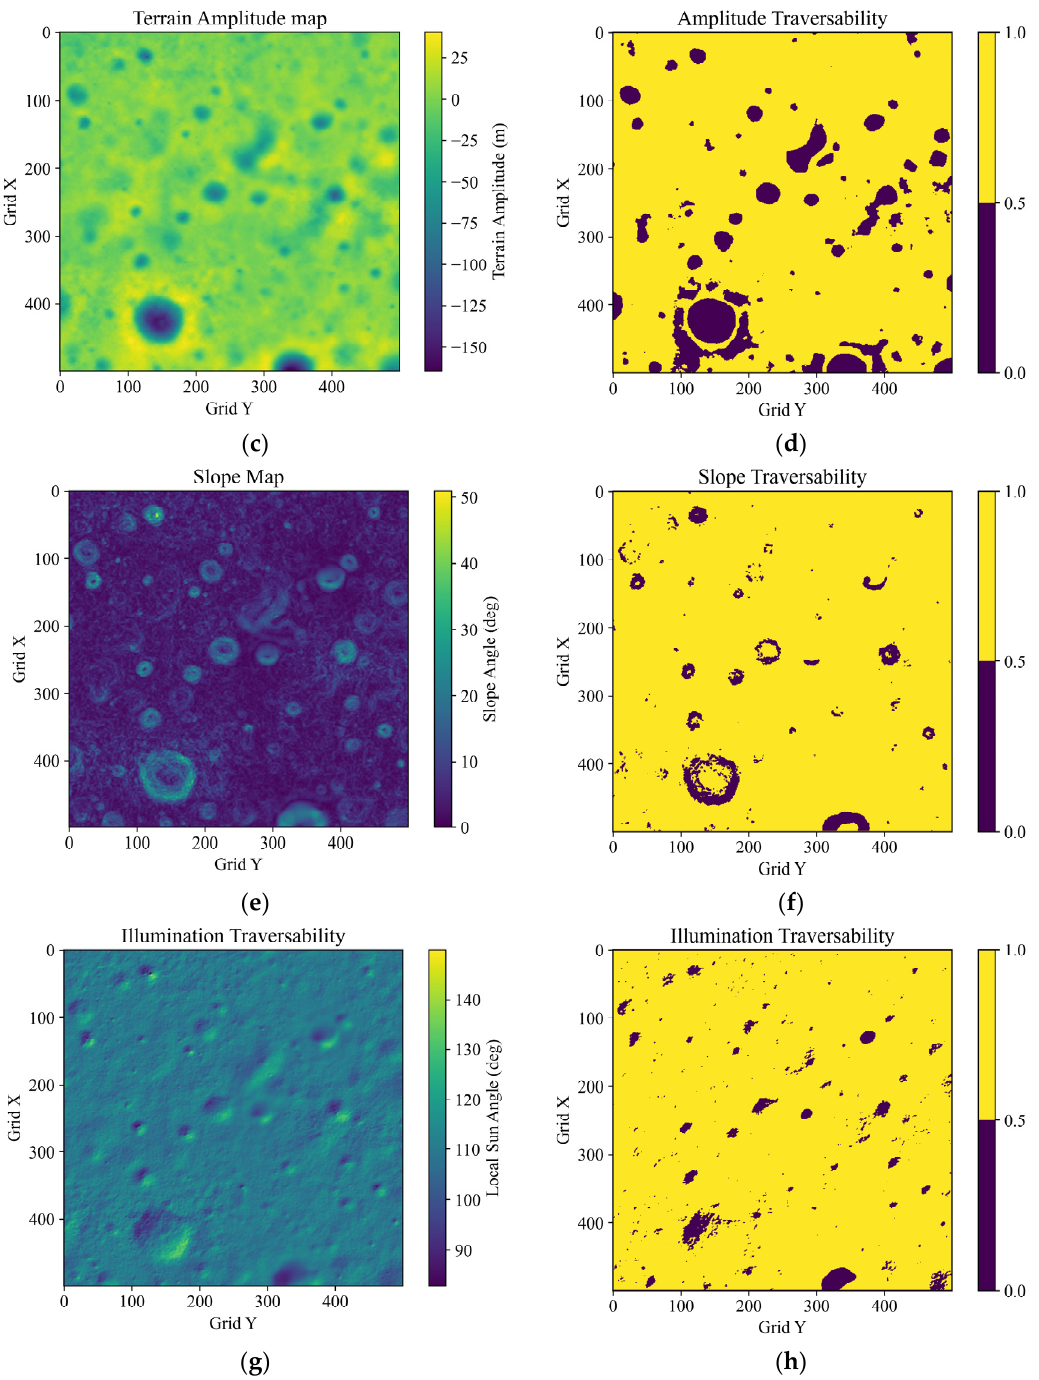
Figure 1. An example of traversability analysis and the feature map: ( a ) the original DEM, ( b ) the feature map, ( c ) the terrain amplitude map, ( d ) the amplitude traversability, ( e ) the slope map, ( f ) the slope traversability, ( g ) the illumination map, and ( h ) the illumination traversability.